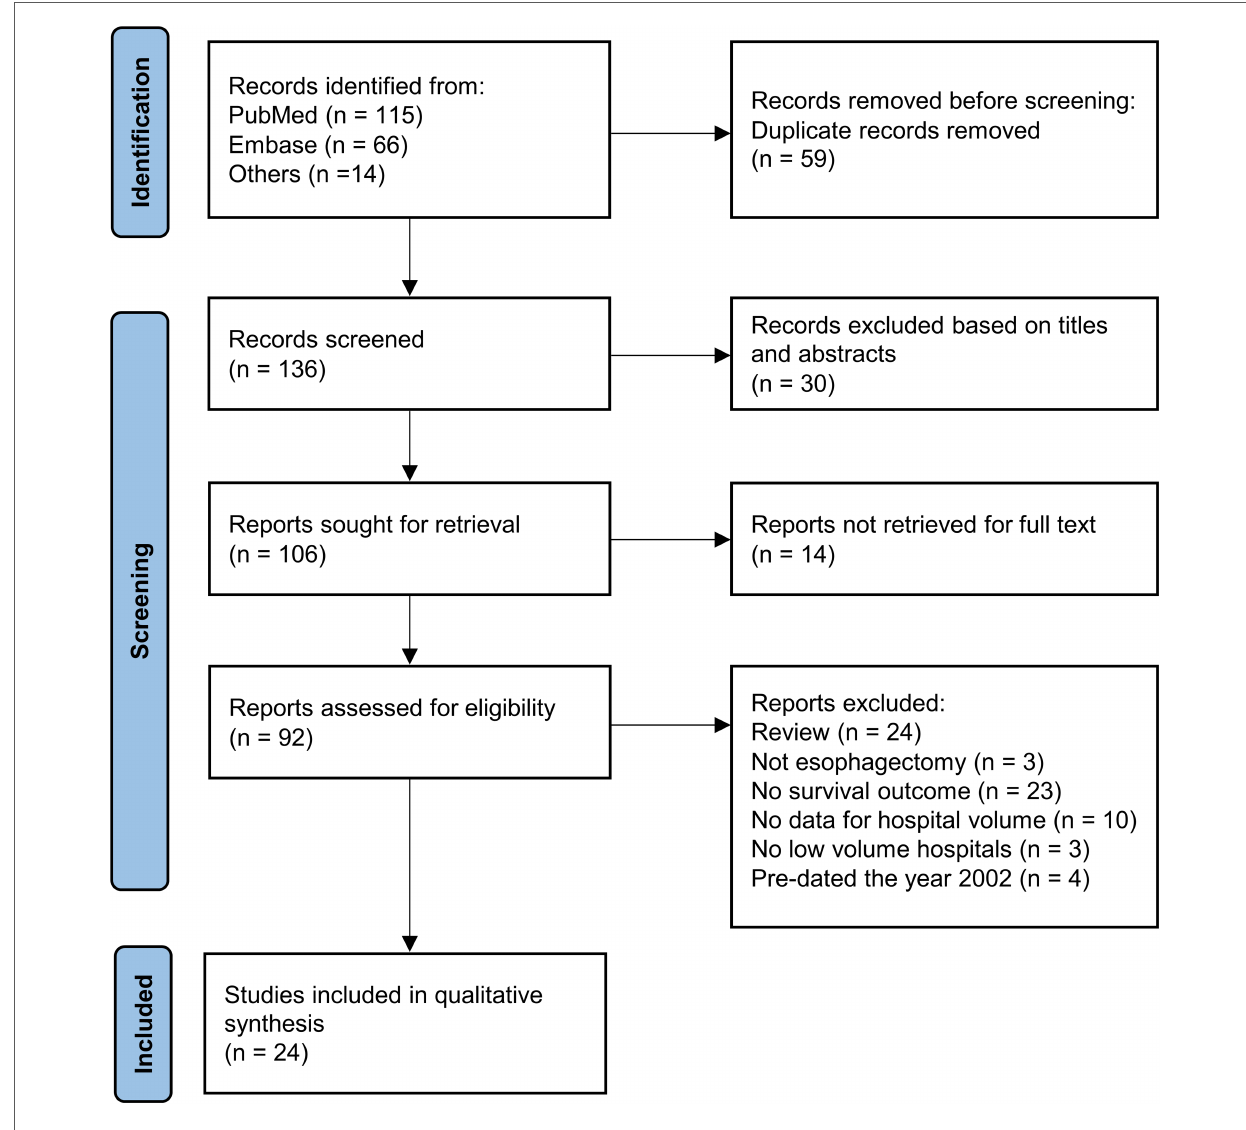
FIGURE 1 The PRIMSA fl ow diagram for included